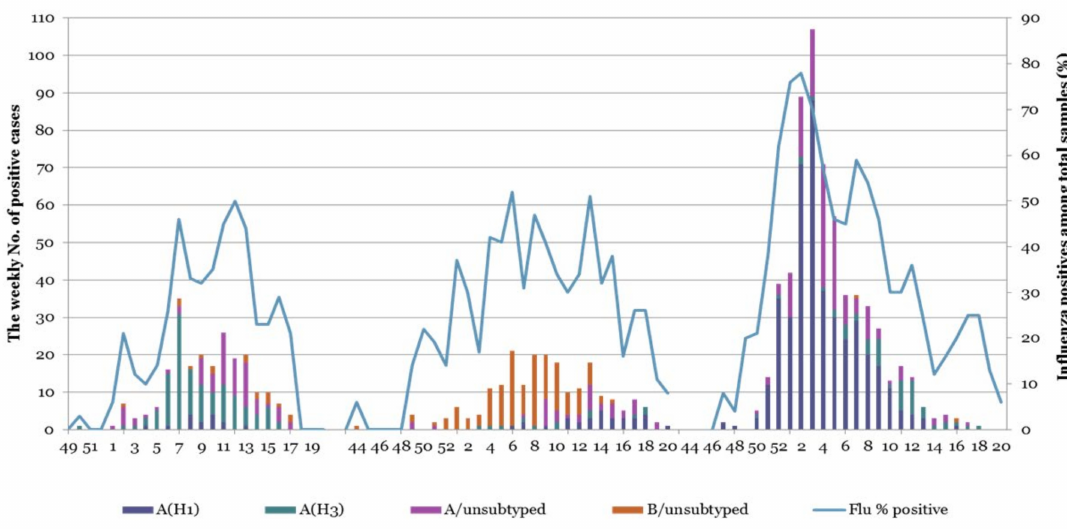
Figure 1. Weekly confirmed cases of influenza in the 2013/14, 2014/15, and 2015/16 seasons in Ukraine among clinical surveillance for ILI in four cities in Ukraine (Kyiv, Dnipro, Odessa, and Khmelnytsky). Influenza type and subtype were determined by RT-PCR and antigenic testing from nasal